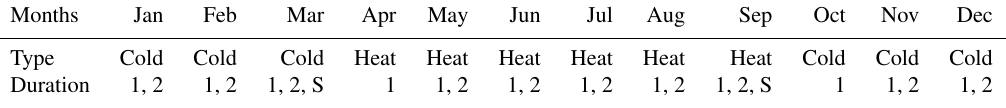
Table 3. Accumulation periods used to calculate the return period of wave intensities. The type of waves (cold or heat) is indicated in the second row and the accumulation period of the sum of intensities is indicated in the last row (1 for 1-month accumulation period, 2 for 2-month accumulation period and S for Season, i.e. 6-month accumulation period).